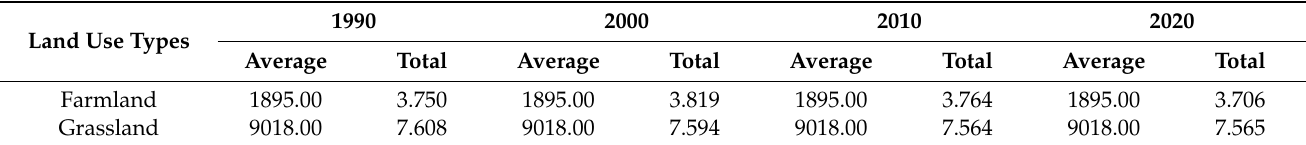
Figure 6. Spatial distribution of average carbon storage in the Yellow River Basin (Henan section): ( a ) carbon storage map for 1990; ( b ) carbon storage map for 2000; ( c ) carbon storage map in 2010. ( d ) carbon storage map for 2020. Table 6. Food supply (10 7 t) and average supply (t/km 2 ) for the land use types for the Yellow River Basin (Henan section) from 1990 to